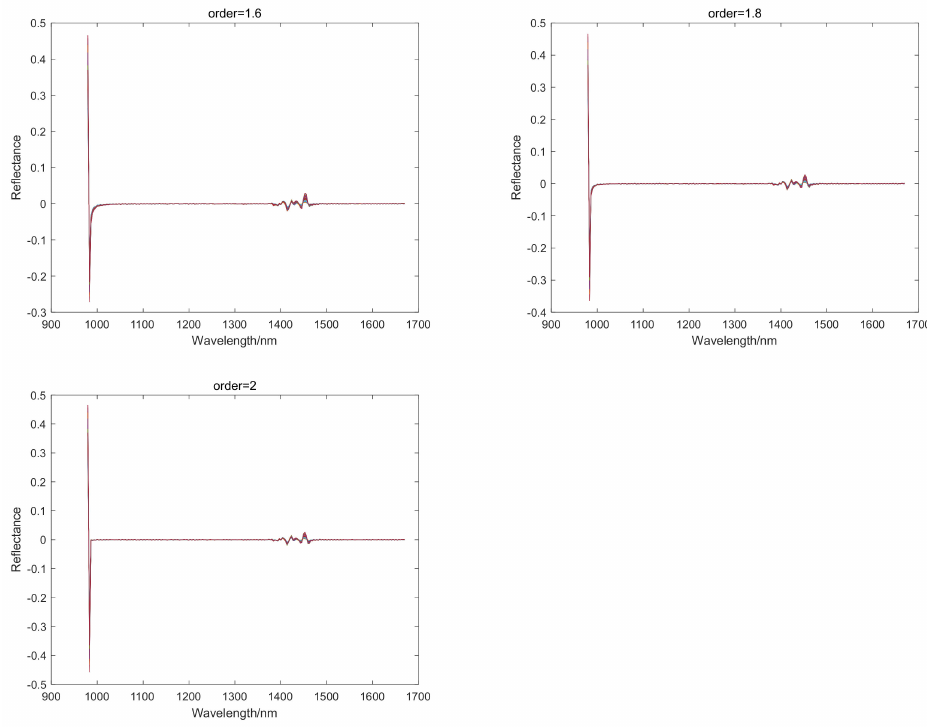
Figure 3. Spectral curves of rubber plantation soils under different